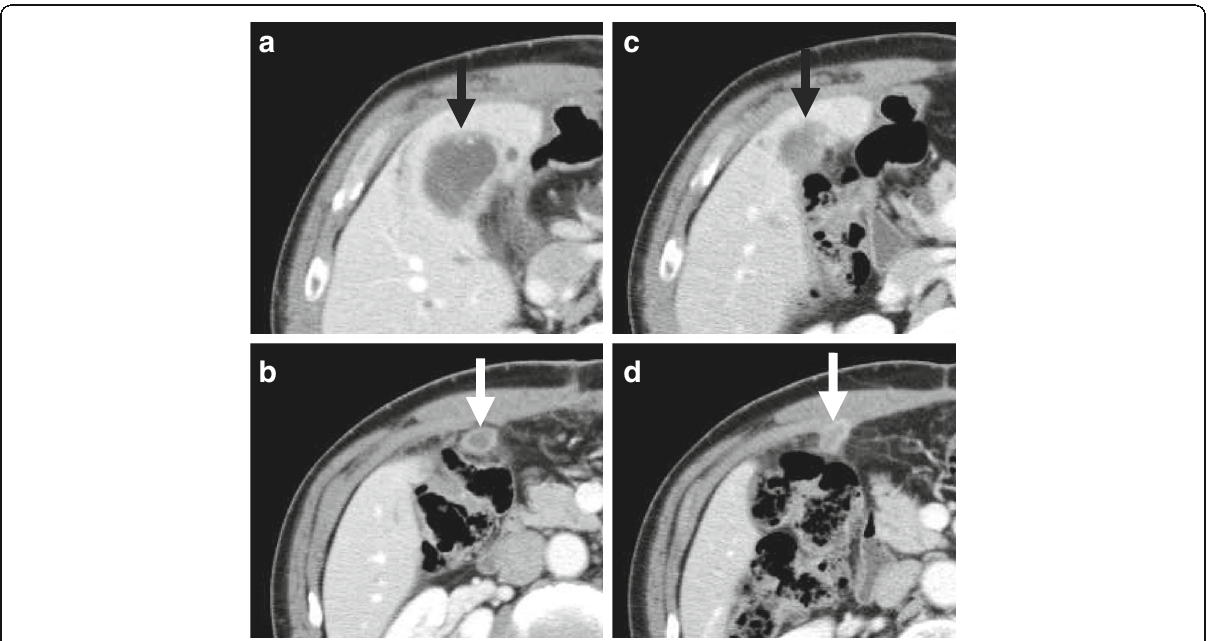
Fig. 2 Comparison of the CT images before and after the chemotherapy. The sum of the longest diameter of the tumours decreased from 57 to 36 mm after chemotherapy. Response Evaluation Criteria in Solid Tumours (RECIST) showed a partial response of the effect ( a , b before chemotherapy; c , d after chemotherapy). Black arrow primary tumour, white arrow peritoneal